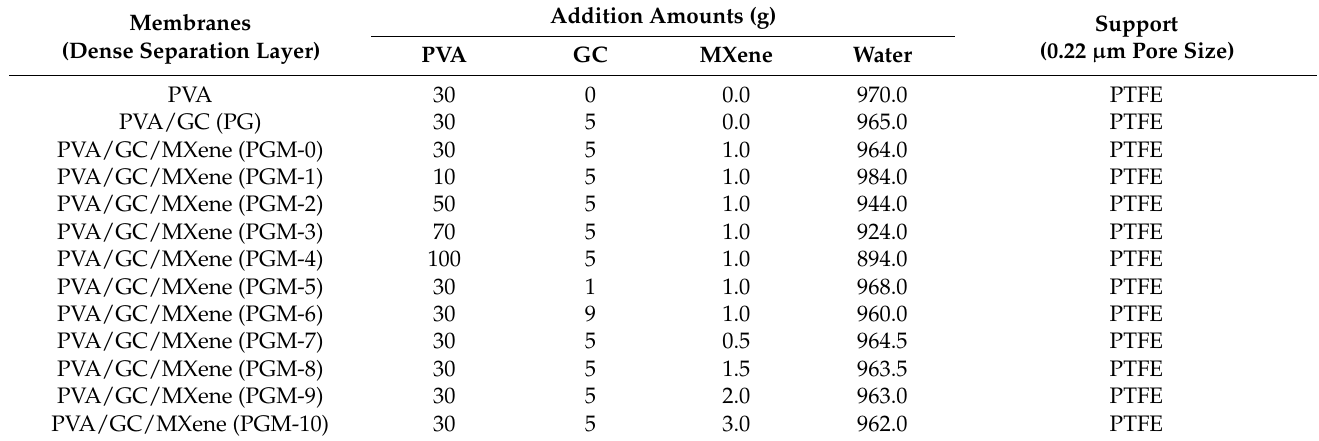
Table 1. The composition of different PVA/GC/MXene composite